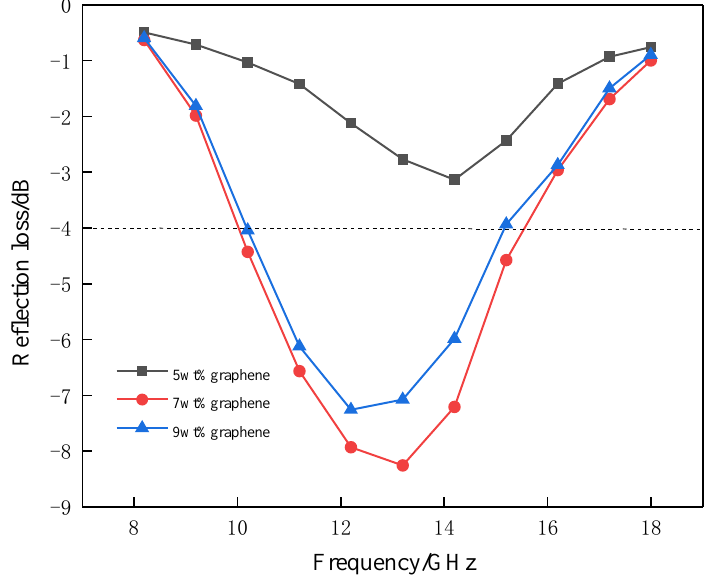
Figure 1. Reflection loss of graphene / PLA composite absorbers with di ff erent graphene Figure. 1 Reflection loss of graphene/PLA composite absorbers with different graphene cont ent.